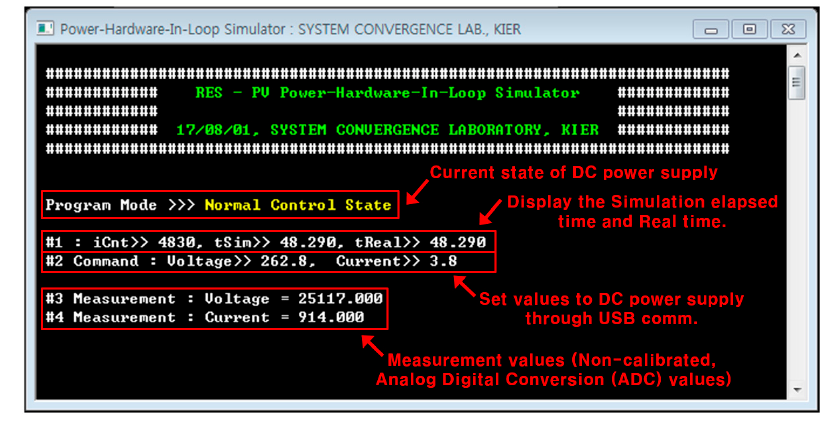
Figure 9. Real-time based PV PHIL Simulator software.